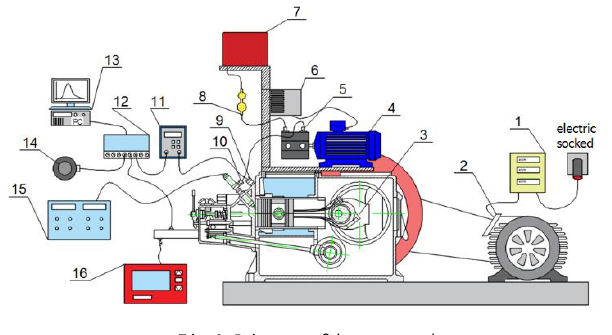
Fig. 2. Diagram of the test stand Table 1. Technical data of the engine